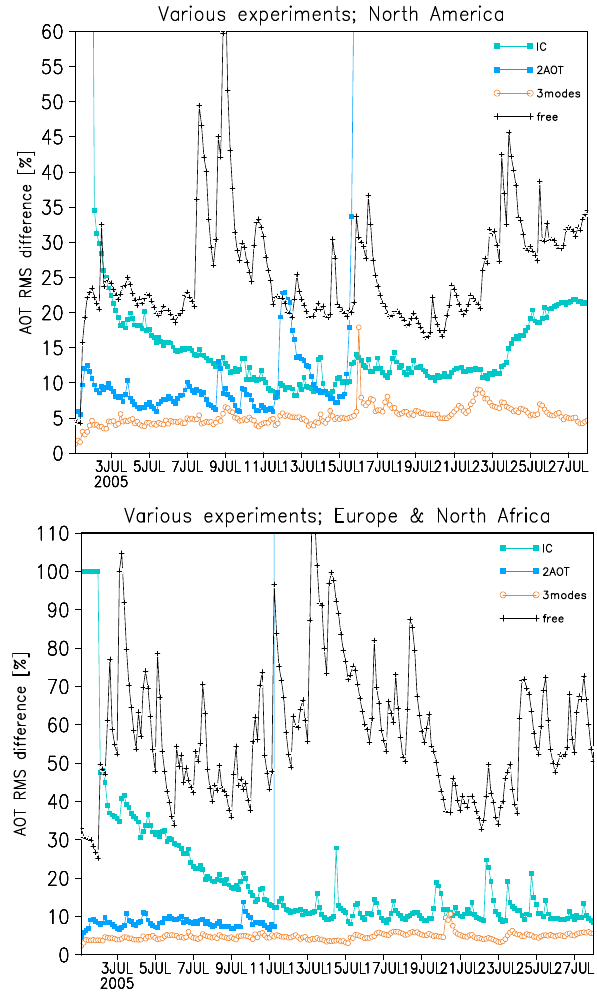
Fig. 9. Area-averaged differences [%] in AOT, for various experiments. The R128E2P4 experiment is used as the reference.